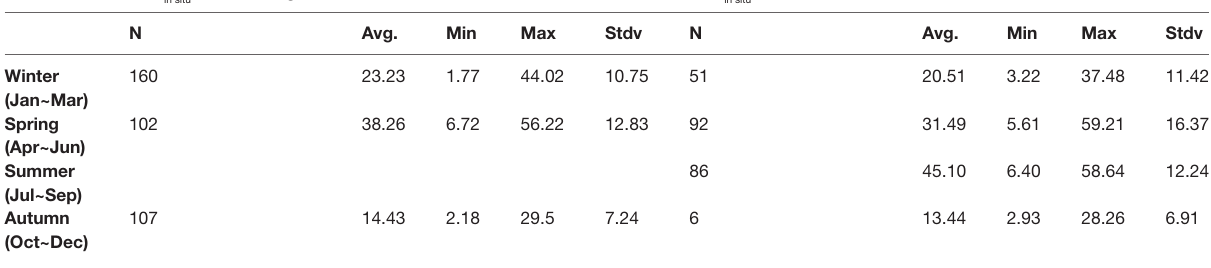
TABLE 2 Seasonal statistics from in situ measurement daily PAR.